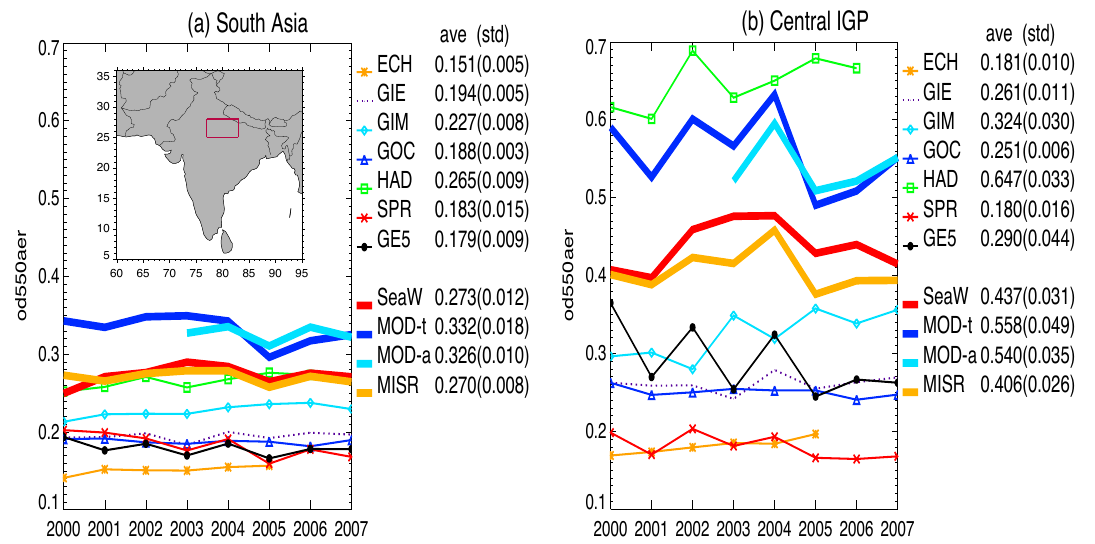
Figure 4. The annual averaged mean AOD for 2000–2007 over region: (a) South Asia (60–95 ◦ E, 5–36 ◦ N; averaged over land only, i.e., the gray area in the map); (b) Central IGP (77–83 ◦ E, 25–28 ◦ N; averaged over the red box on the map shown in Fig. 4a). Thin lines with symbols represent seven models, and thick lines represent four satellite data sets. Multi-year averaged mean AOD and the standard deviation is listed on each